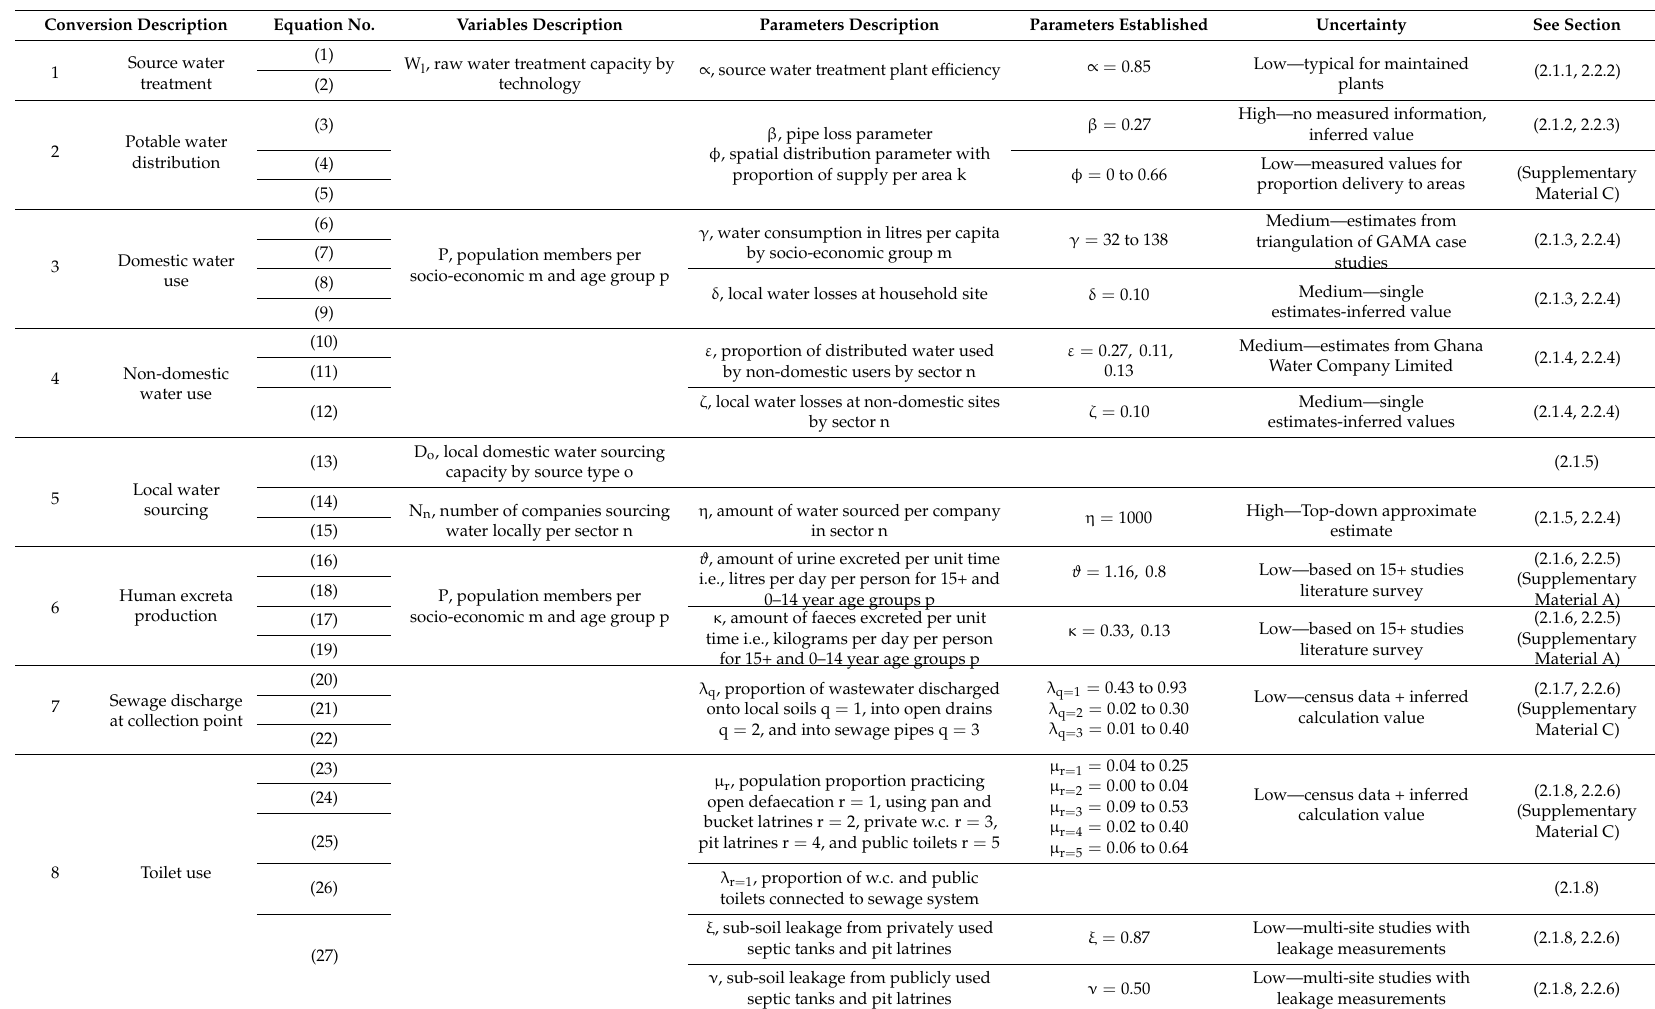
Table 1. Overview of variables and parameters established in the